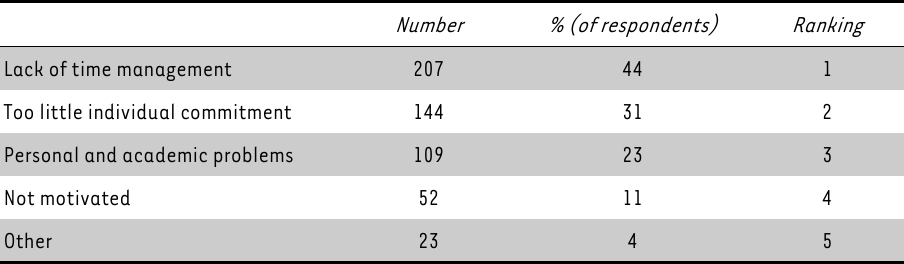
Factors hindering own success Number % (of respondents) Ranking Lack of time management 207 44